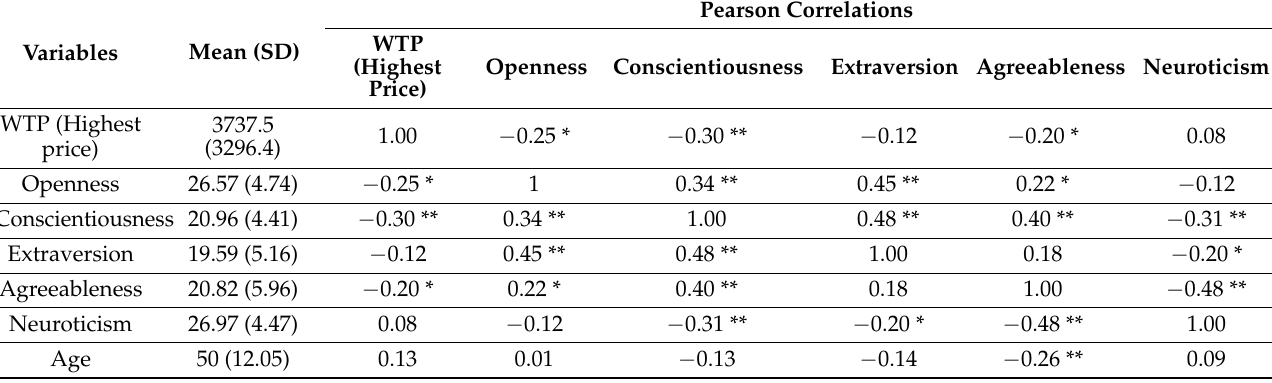
Table 3. Correlation of personality traits with the highest price subjects are willing to